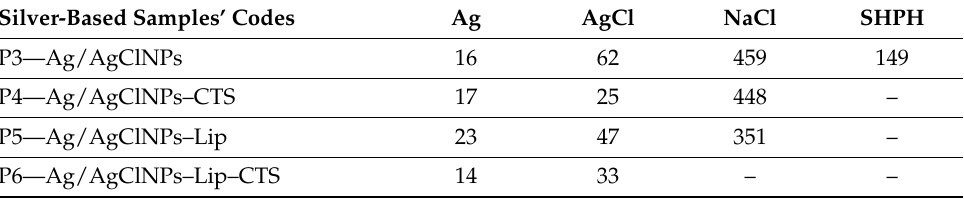
Table 2. Mean sizes of crystallites (D XRD , nm) estimated from diffraction line broadening. Silver-Based Samples’ Codes